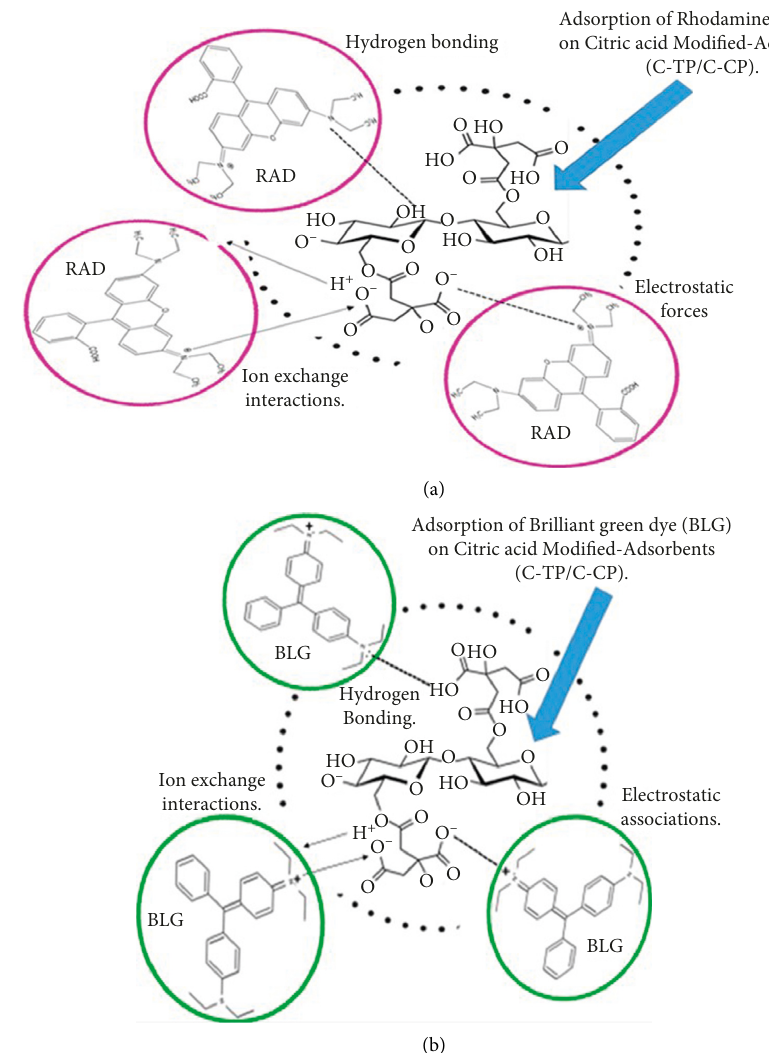
Figure 20: Schematic diagram for the adsorption mechanism. (a) RAD on C-TP and C-CP. (b) BLG on C-TP and